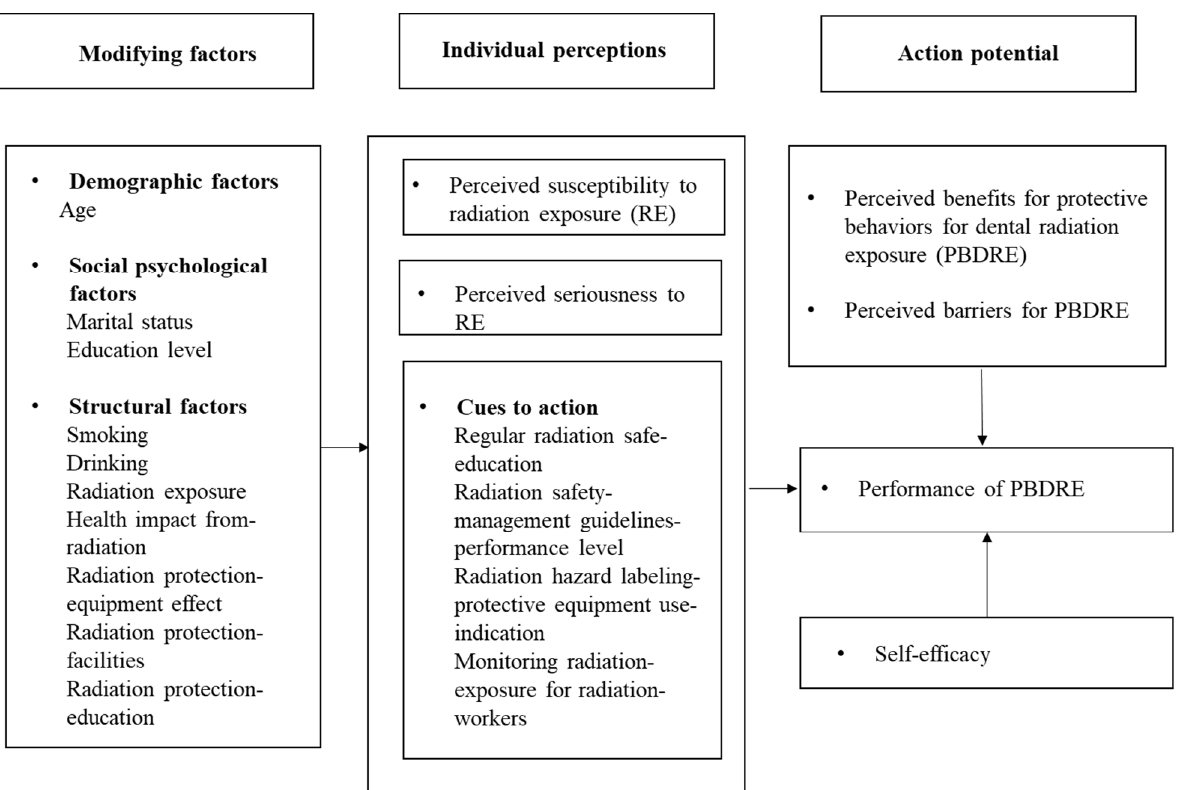
Figure 1. Theoretical framework of study using HBM. RE = radiation exposure; PBDRE = protective behaviors for dental radiation exposure.